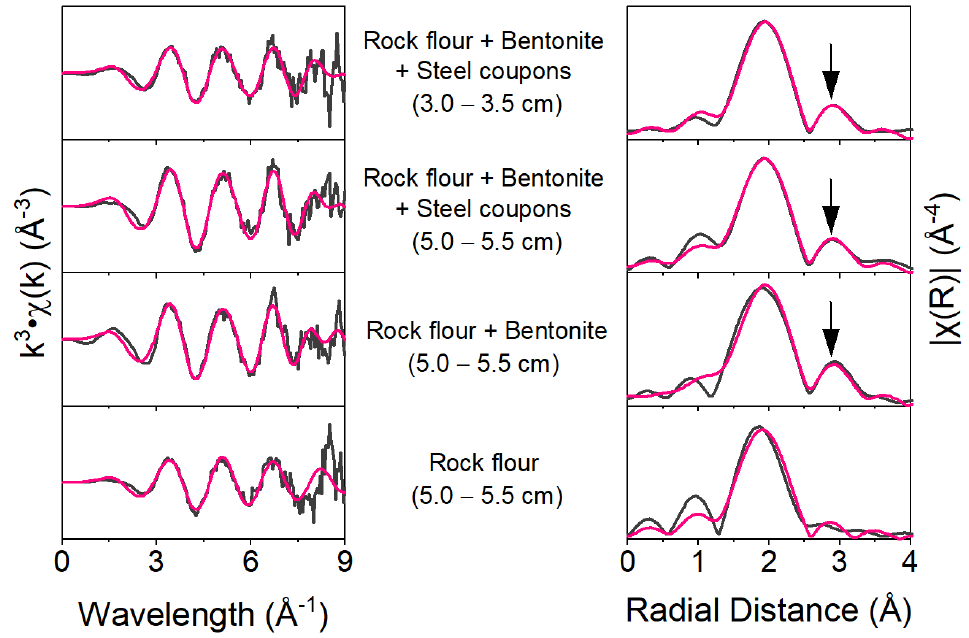
Figure 4. Sr K-edge EXAFS spectra for column material samples and best fits for k 3 weighted data ( left ) and their Fourier transforms (FT) ( right ). Fits are detailed in Supplementary Materials Table S4. Experimental data are shown in black, and best fits (Supplementary Materials Table S4) are in red. The arrow in the Fourier transform indicates the presence of a Si/Al shell.